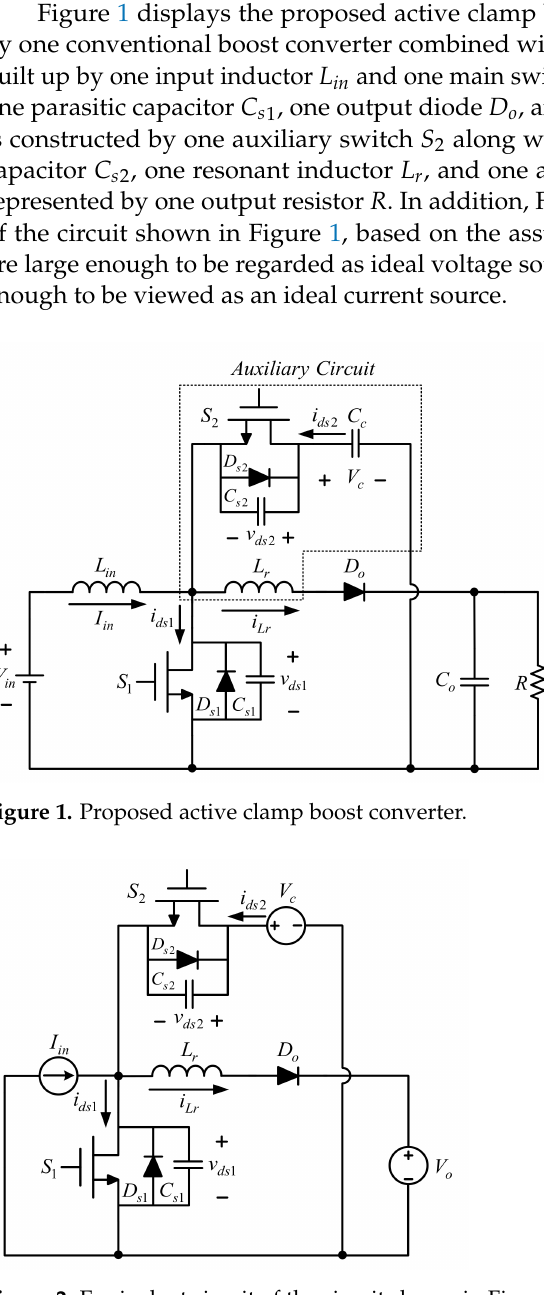
Figure 2. Equivalent circuit of the circuit shown in Figure